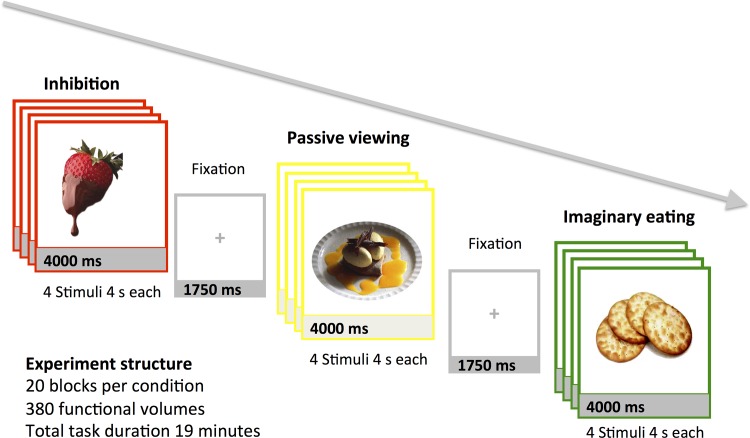
Experimental design and trial structure.